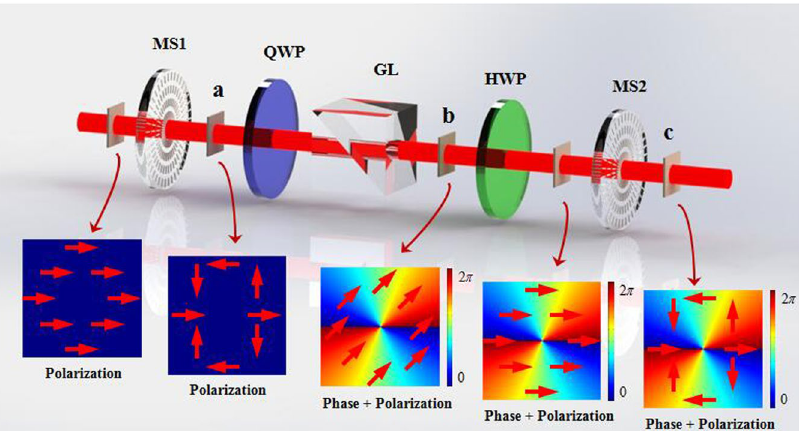
Figure 10. The optical system applied to switch CVB into VB and obtain VB, CVB and CVV beam in one system. MS: metasurface; QWP: quarter-wave plate; GL: Glan laser polarizer; HWP: half-wave plate. The first metasurface was used to generate CVB. Combinations of QWP, GL and HWP are used to convert the CVB to horizontal linear polarized VB. The second metasurface was used to generate CVV beam by incident the horizontal linear polarization VB. Insets show the polarization and phase patterns in each step of this